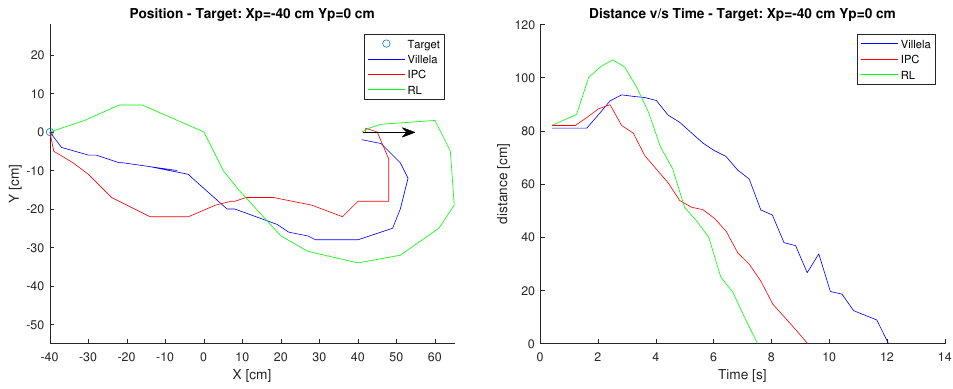
Figure 14. Position and distance to target X p = − 40 cm, Y p = 0 cm.